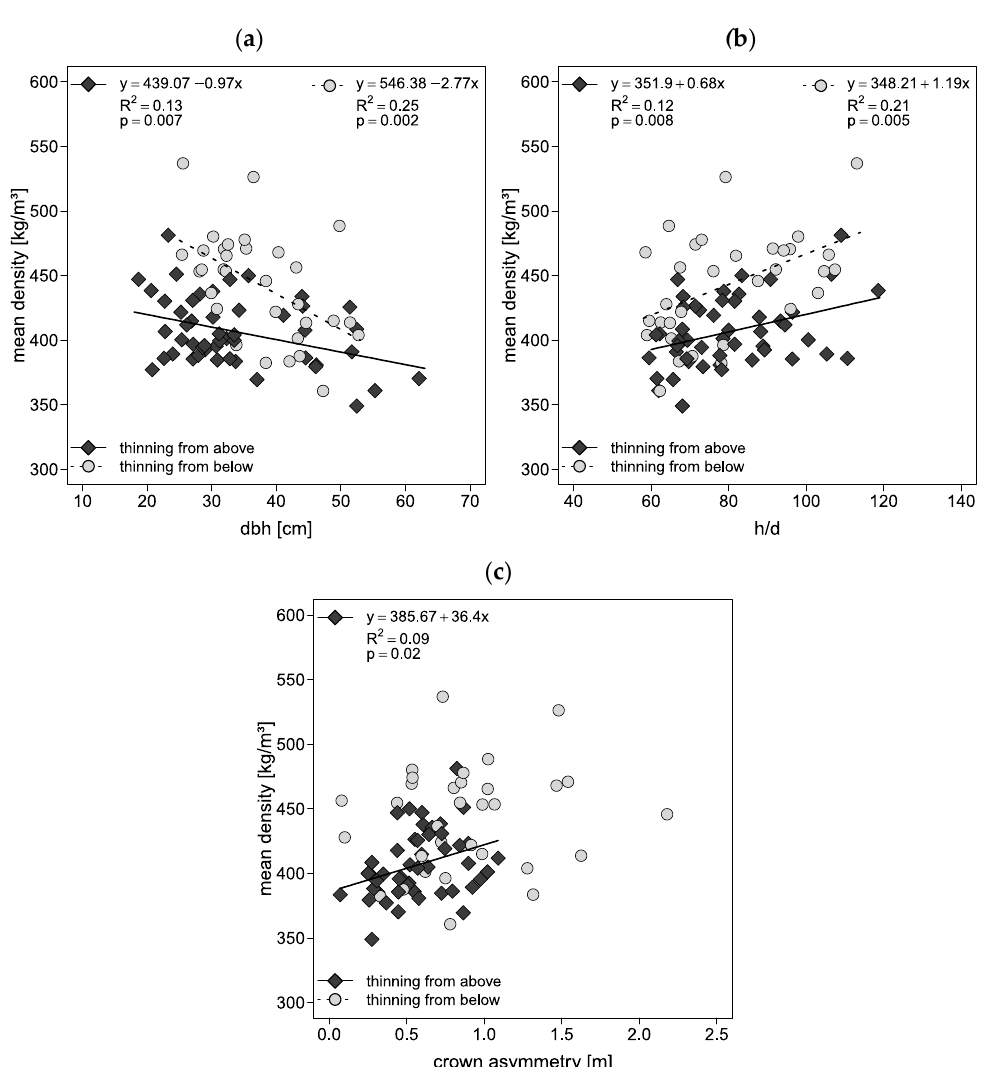
Figure 9. Relationship between mean density (at CBH) and the tree morphology attributes ( a ) diameter at breast height (DBH), ( b ) height-to-diameter ratio (h/d ratio), and ( c ) crown asymmetry. Regression models were computed separately for plots with different silvicultural treatment (TFA and TFB). The lines refer to the applied linear regression models showing only significant relationships at p < 0.05.